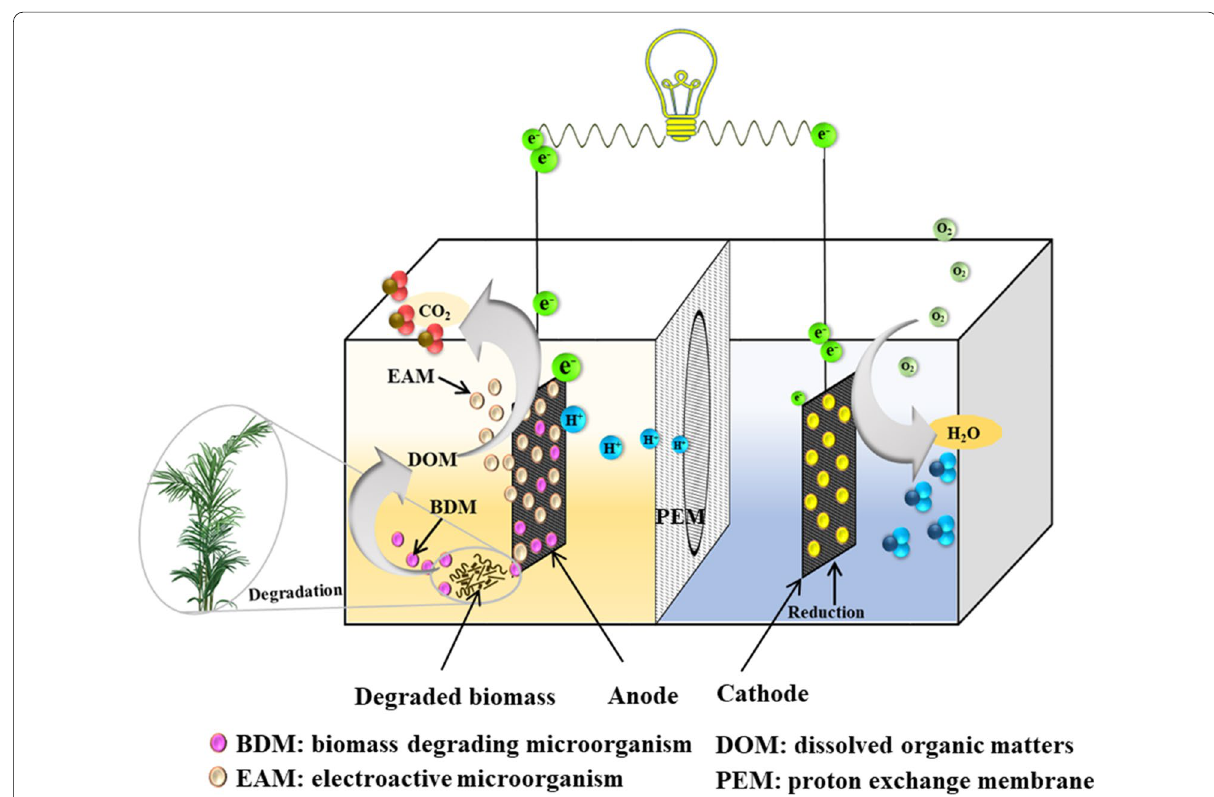
Fig. 1 Model for biomass‑fueled proton exchange membrane (PEM) separated microbial fuel cell (MFC). The electroactive microorganisms (EAMs) formed EAMs biofilm and were responsible for the degradation of biomass in the